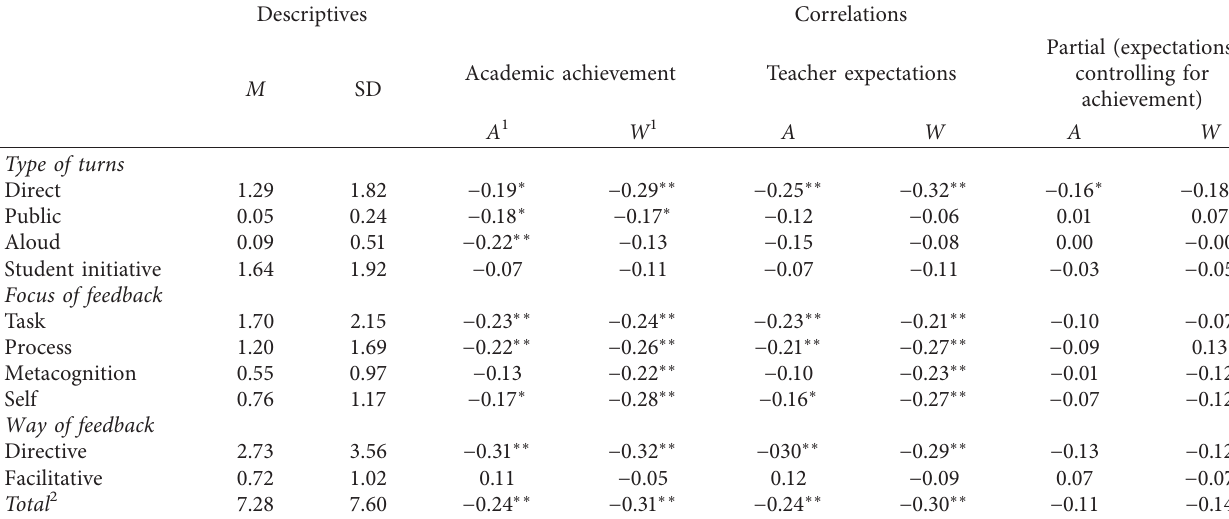
Table 4: Descriptive statistics for teacher-student interactions during individual work and bivariate and partial correlations with academic achievement and teacher expectations, across ( A ) and within ( W ) classrooms ( N � 152).